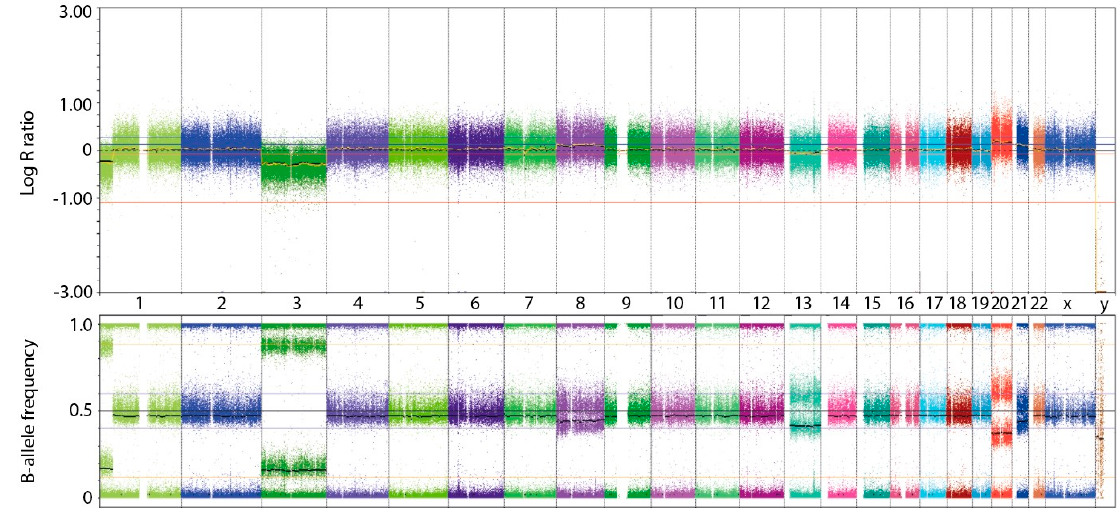
Figure 5. SNP-array profile of a uveal melanoma with partial loss of chromosome 1p and loss of chromosome 3. The x -axis represents the chromosomes. The upper figure displays the Log R ratio; in the lower figure, the B-allele frequency is showed.